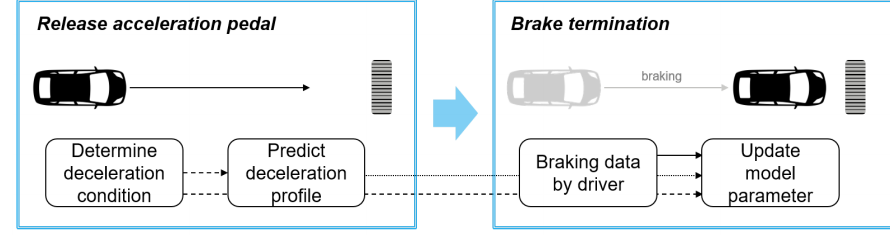
Figure 23. Overview of the methodology presented in [38].